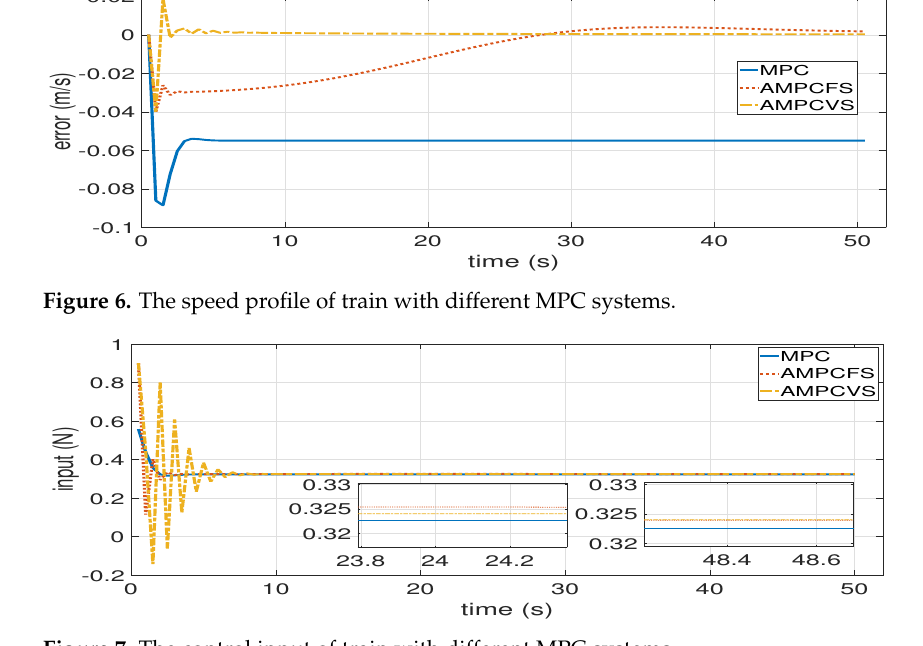
from its predecessor. Thus, it is unacceptable to allow the distance to become greater (beyond communication range) or smaller (irrevocable emergent braking). The AMPCVS well regulates the distance between trains in an acceptable range, shown in Figure 9b. Although the speed of follower trains with AMPCVS varies a little more drastically than MPC, the distance keeps as desired